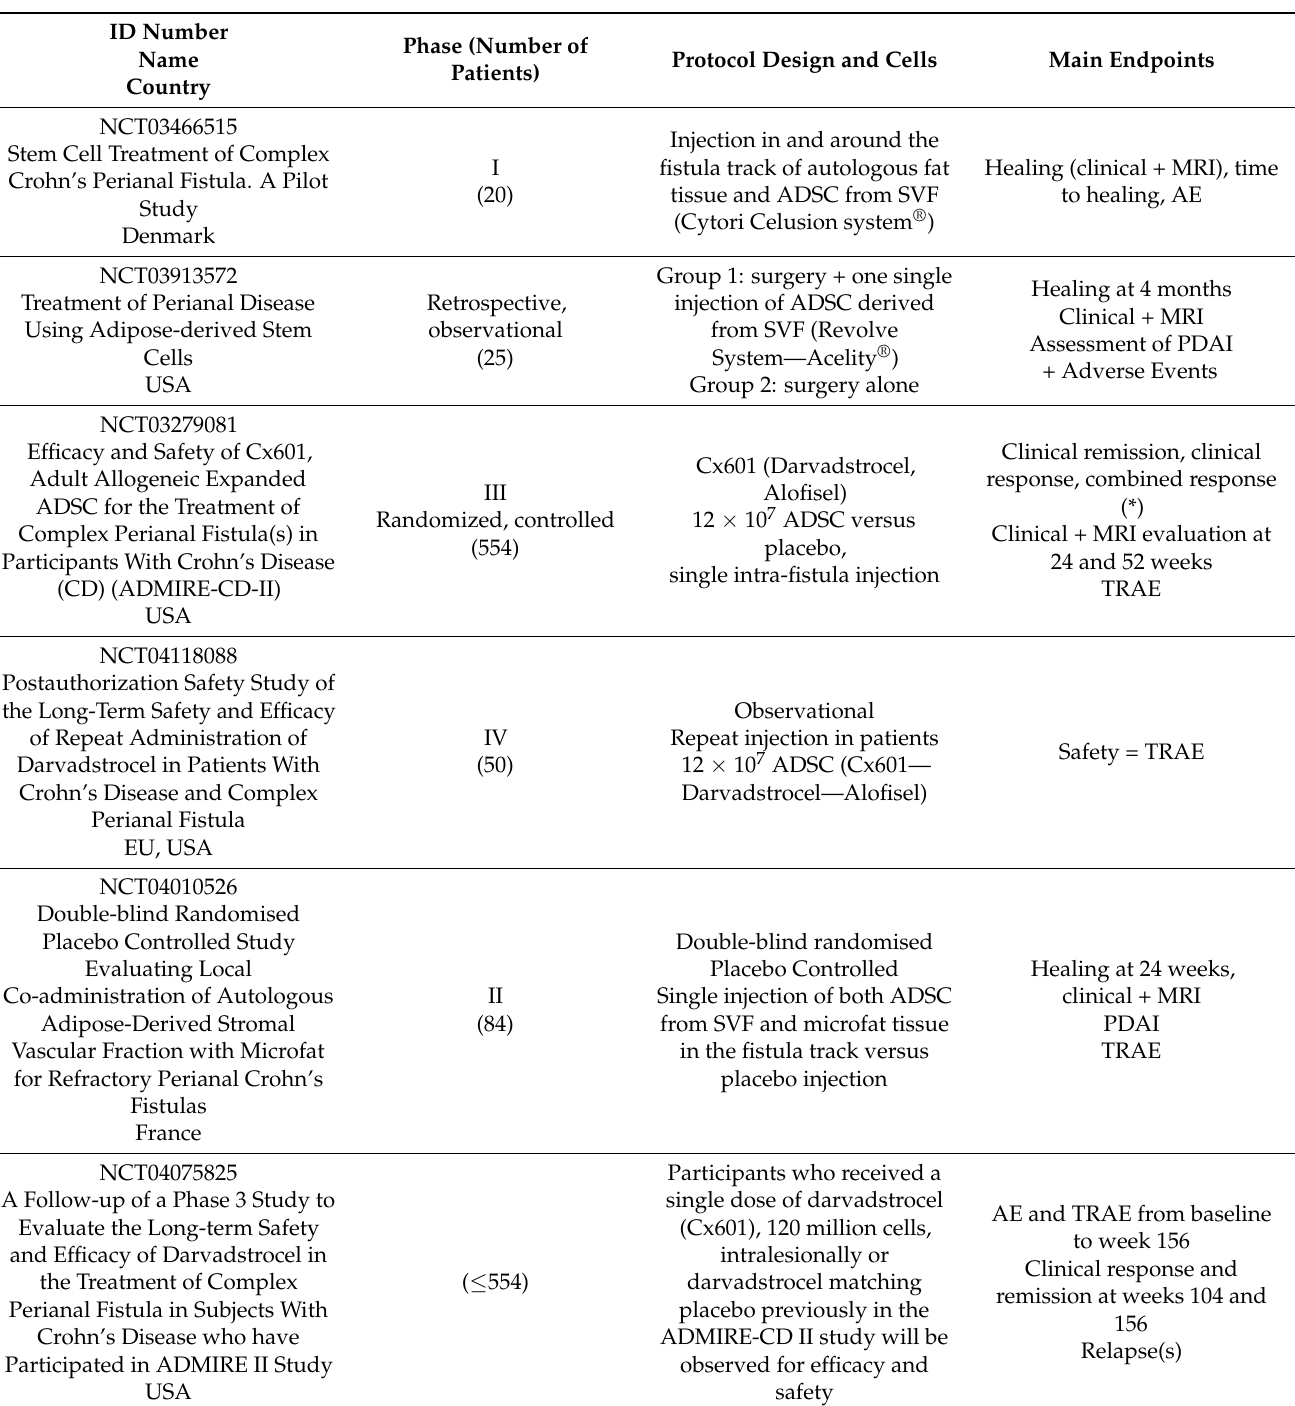
Table 2. Main ongoing trials applying adipose-derived stem cells for Crohn’s disease anoperineal